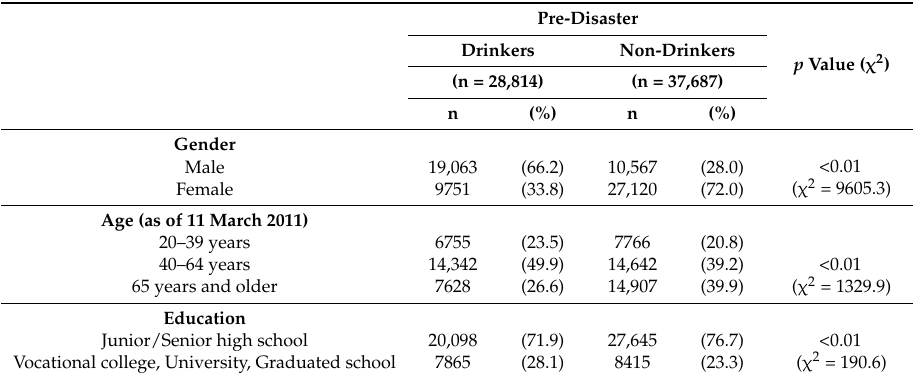
Table 1. Demographic characteristics of